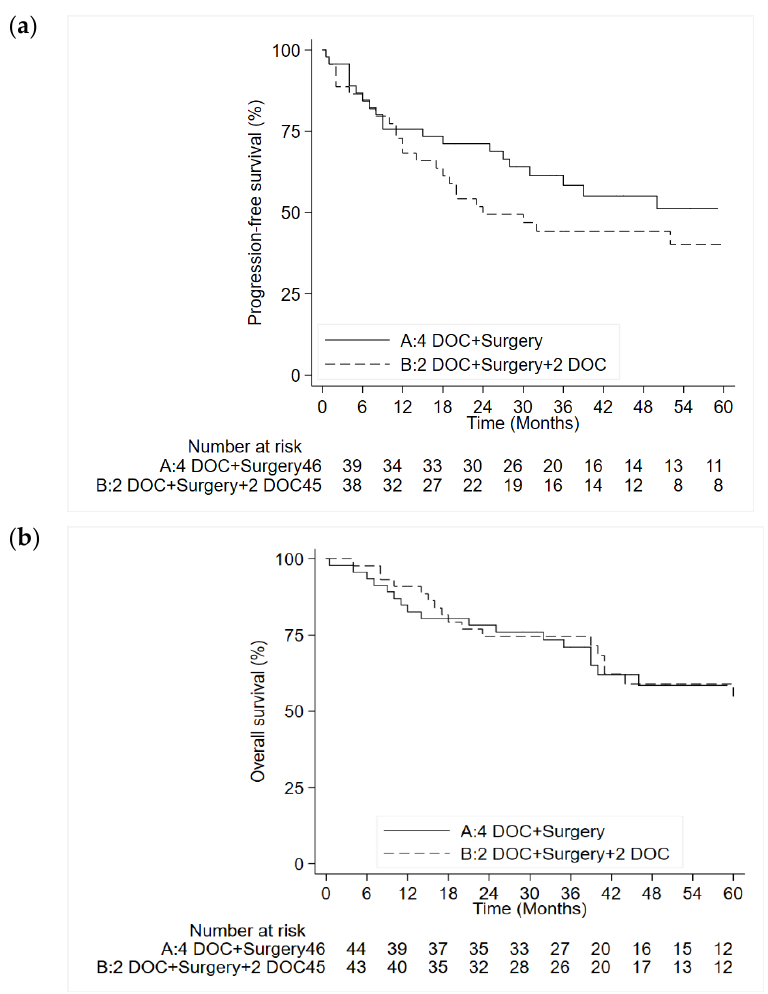
Figure 2. ( a ). Overall survival. ( b ). Progression-free survival. DOC: docetaxel, oxaliplatin, Figure 2. ( a ). Progression-free survival. ( b ). Overall survival. DOC: docetaxel, oxaliplatin, capecitabine.